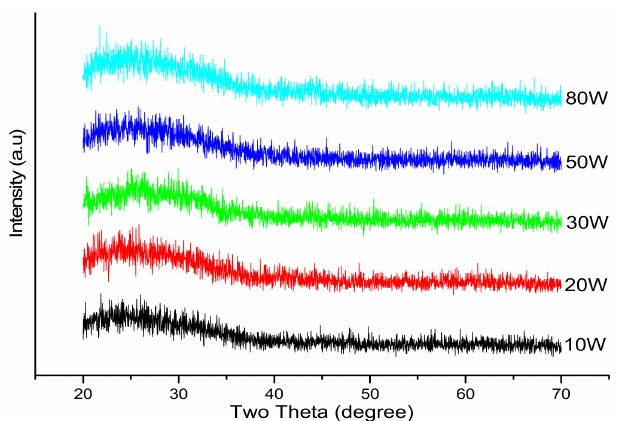
Figure 3. The XRD patterns of the Ni-V-O mixed oxide film with various sputtering powers toward the Ni